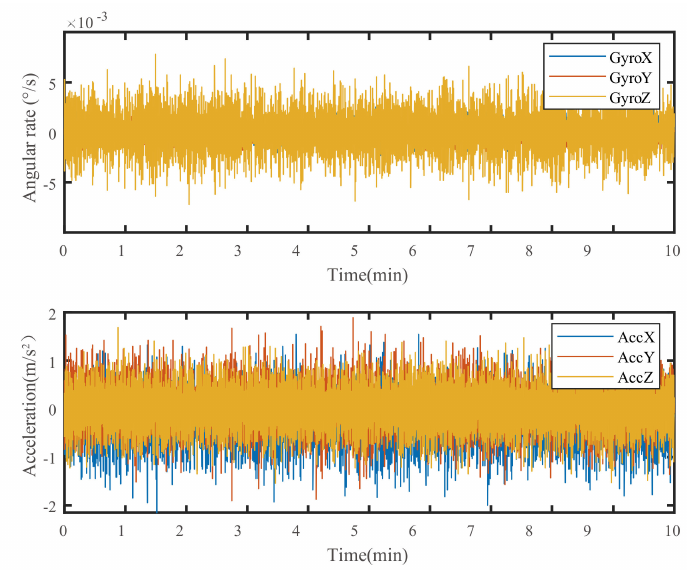
Figure 4. The vibration noise data of the vibration experiment of each